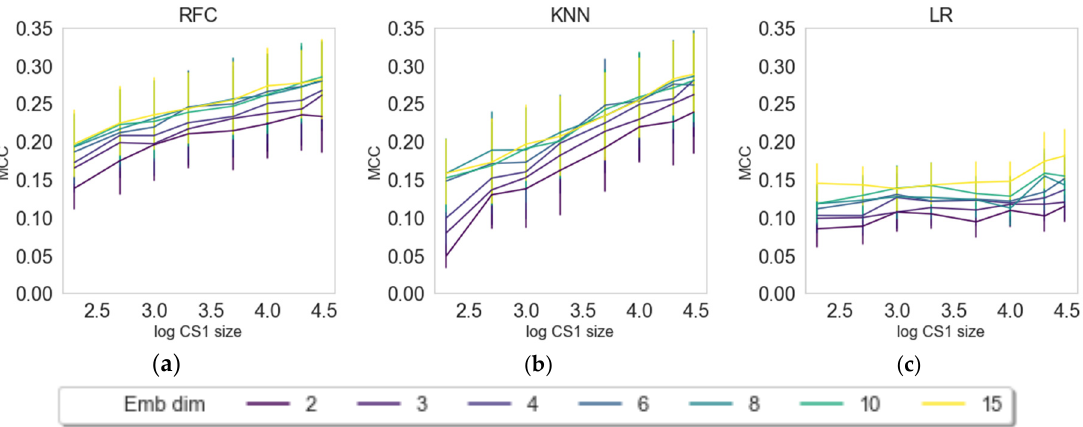
Figure 3. Dependence of classification results or transferred embeddings of CS2 by means of MCC on the log-size of CS1 and dimensions of the UMAP embeddings. The three figures represent three classifying algorithms, namely, ( a ) RFC, ( b ) LR, and ( c ) KNN.